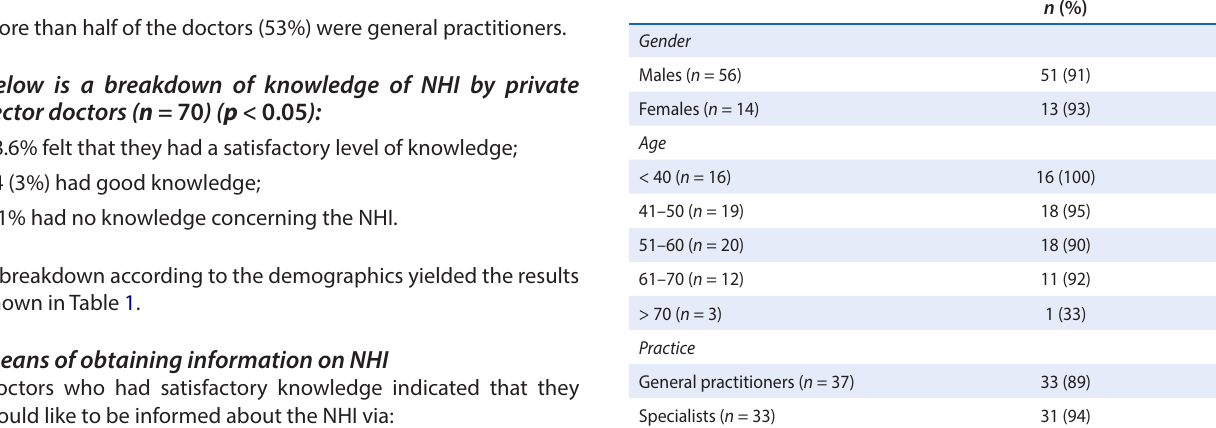
Table 2: Respondents’ awareness of the National Health Insurance scheme according to gender, age and practice ( n = 70)